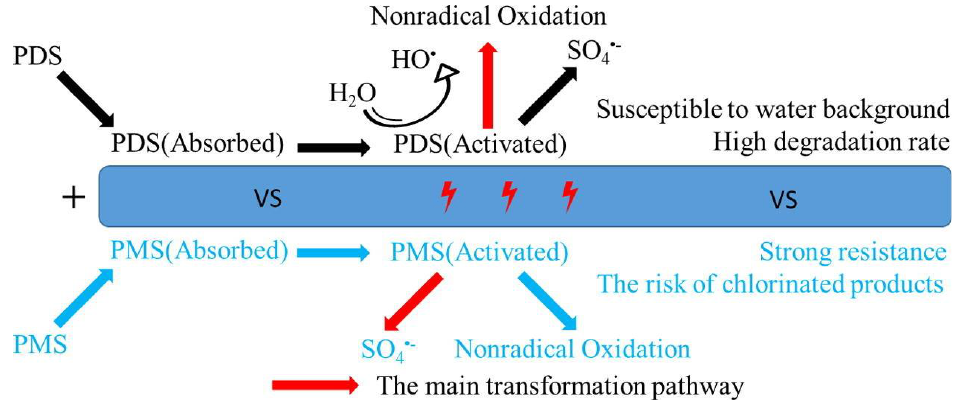
Figure 5. Electrochemically activated PMS and PDS generate active substances for degrading pollutants. Reprinted with permission from ref [34]. Copyright 2020 Elsevier B.V.